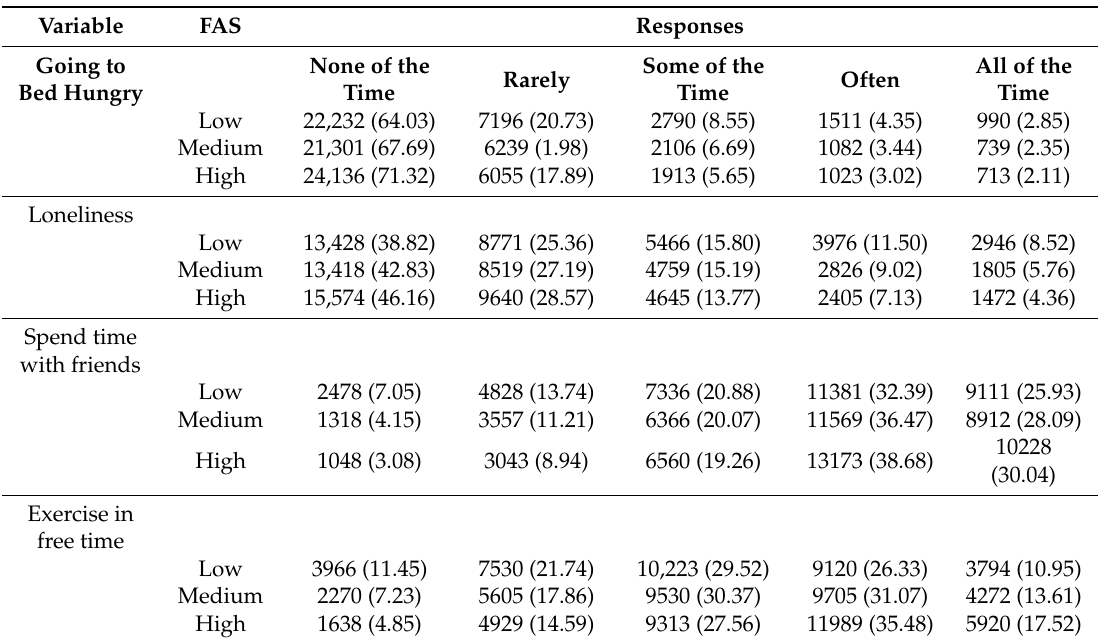
Table 2. Summer holiday experiences according to Family Affluence Scale (FAS) score.